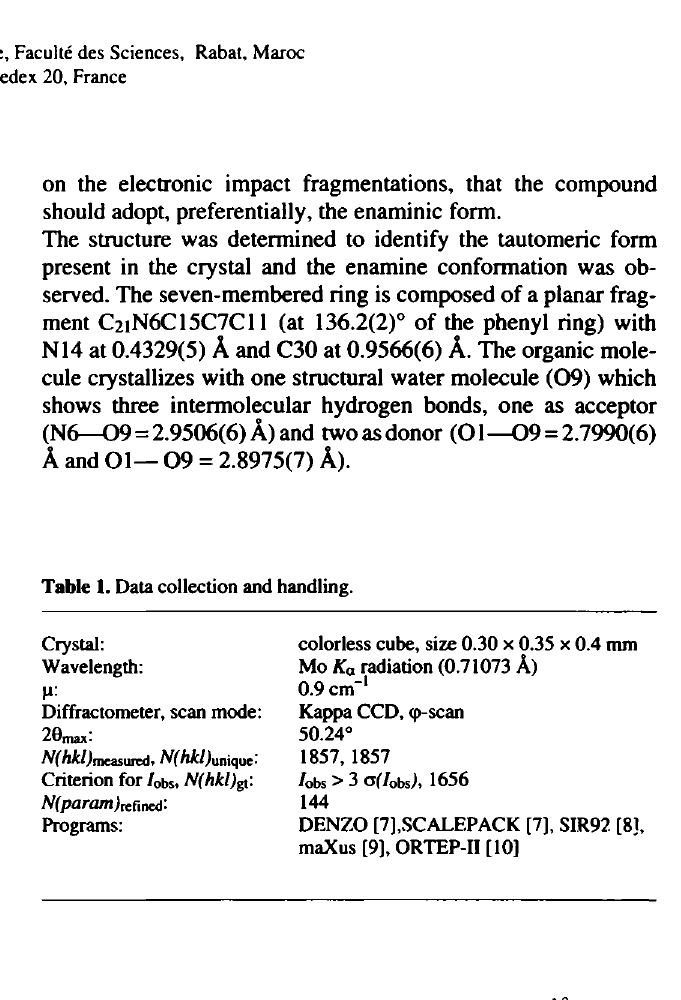
Table 2. Atomic coordinates and displacement parameters (in A 2